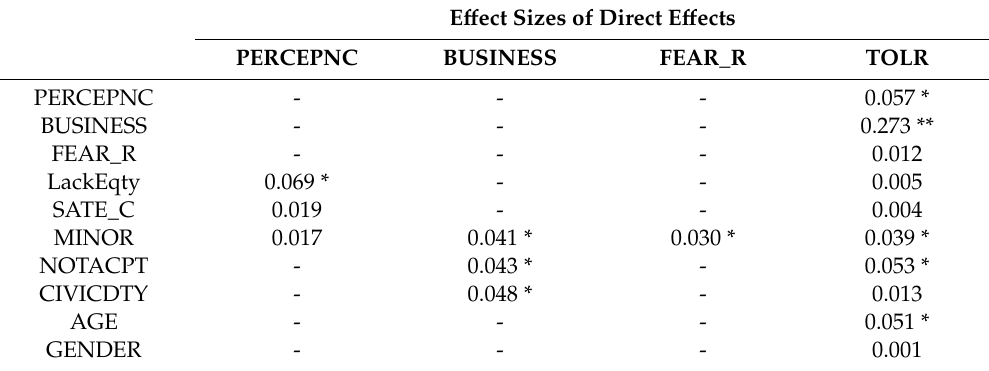
Table 6. E ff ect sizes of direct e ff ects. E ff ect Sizes of Direct E ff ects